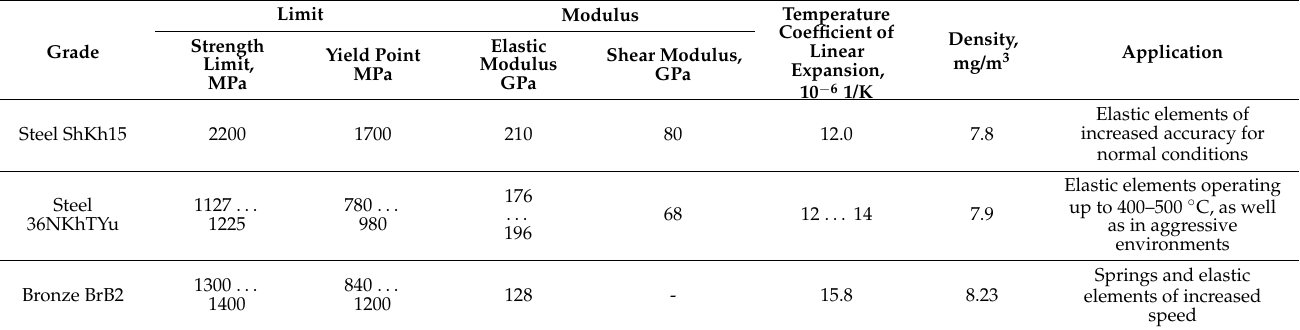
Table 2. Physical and mechanical characteristics of some alloys.